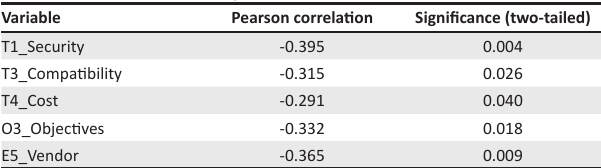
TABLE 3: Correlation between year and constructs. Variable Pearson correlation Significance